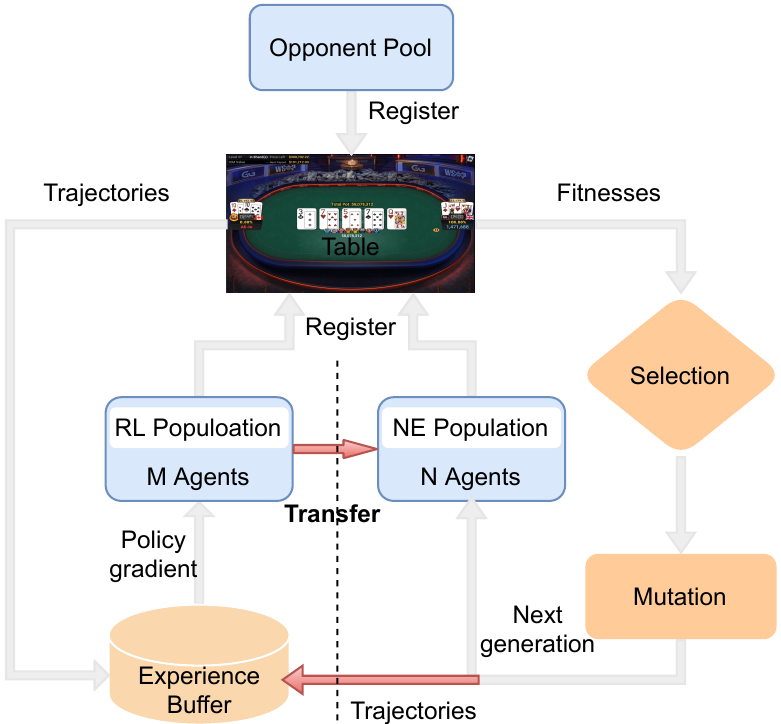
Figure 1. High-level illustration of the NE_RL method for opponent exploitation in